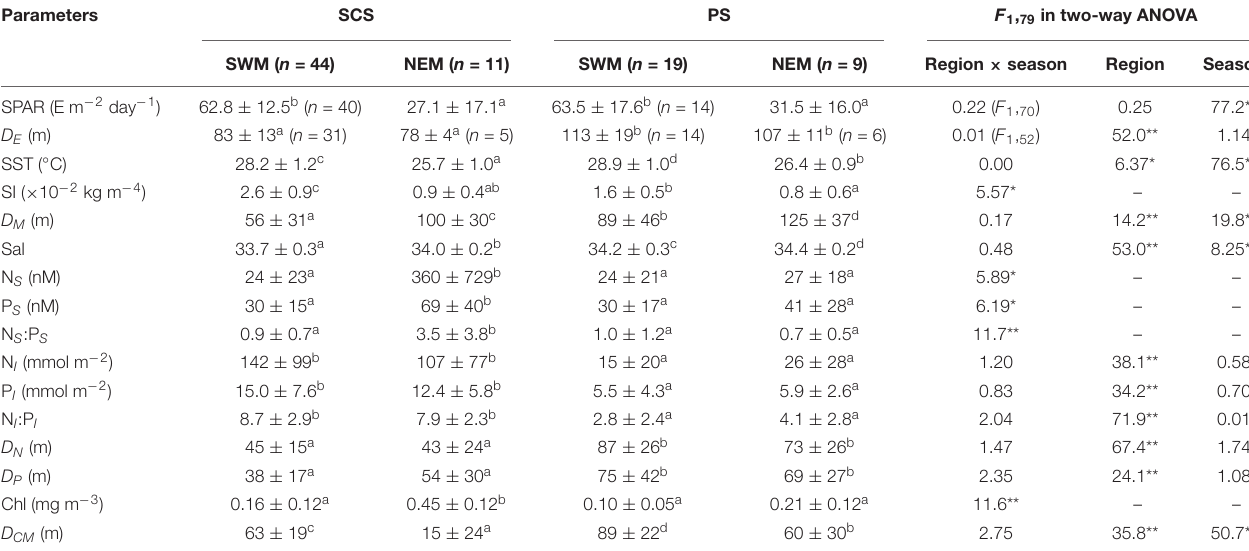
TABLE 3 | Hydrographic and biogeochemical properties in the SCS and the PS during SWM and NEM.